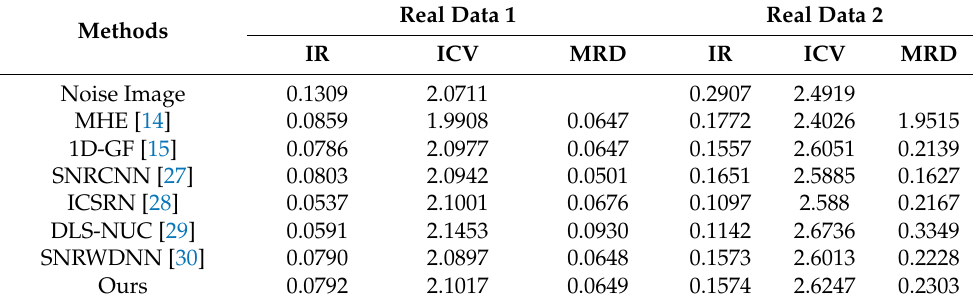
Table 3. Evaluation metrics results of the methods on real data.